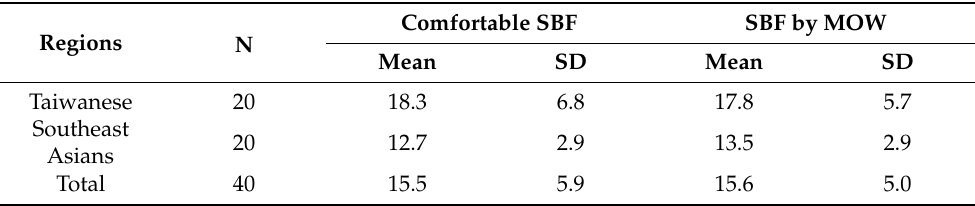
Table 2. Mean (standard deviation; SD) of overall stability index based on two span between feet (SBF) levels (Comfortable _SBF vs. SBF by maximum outer width [MOW]).